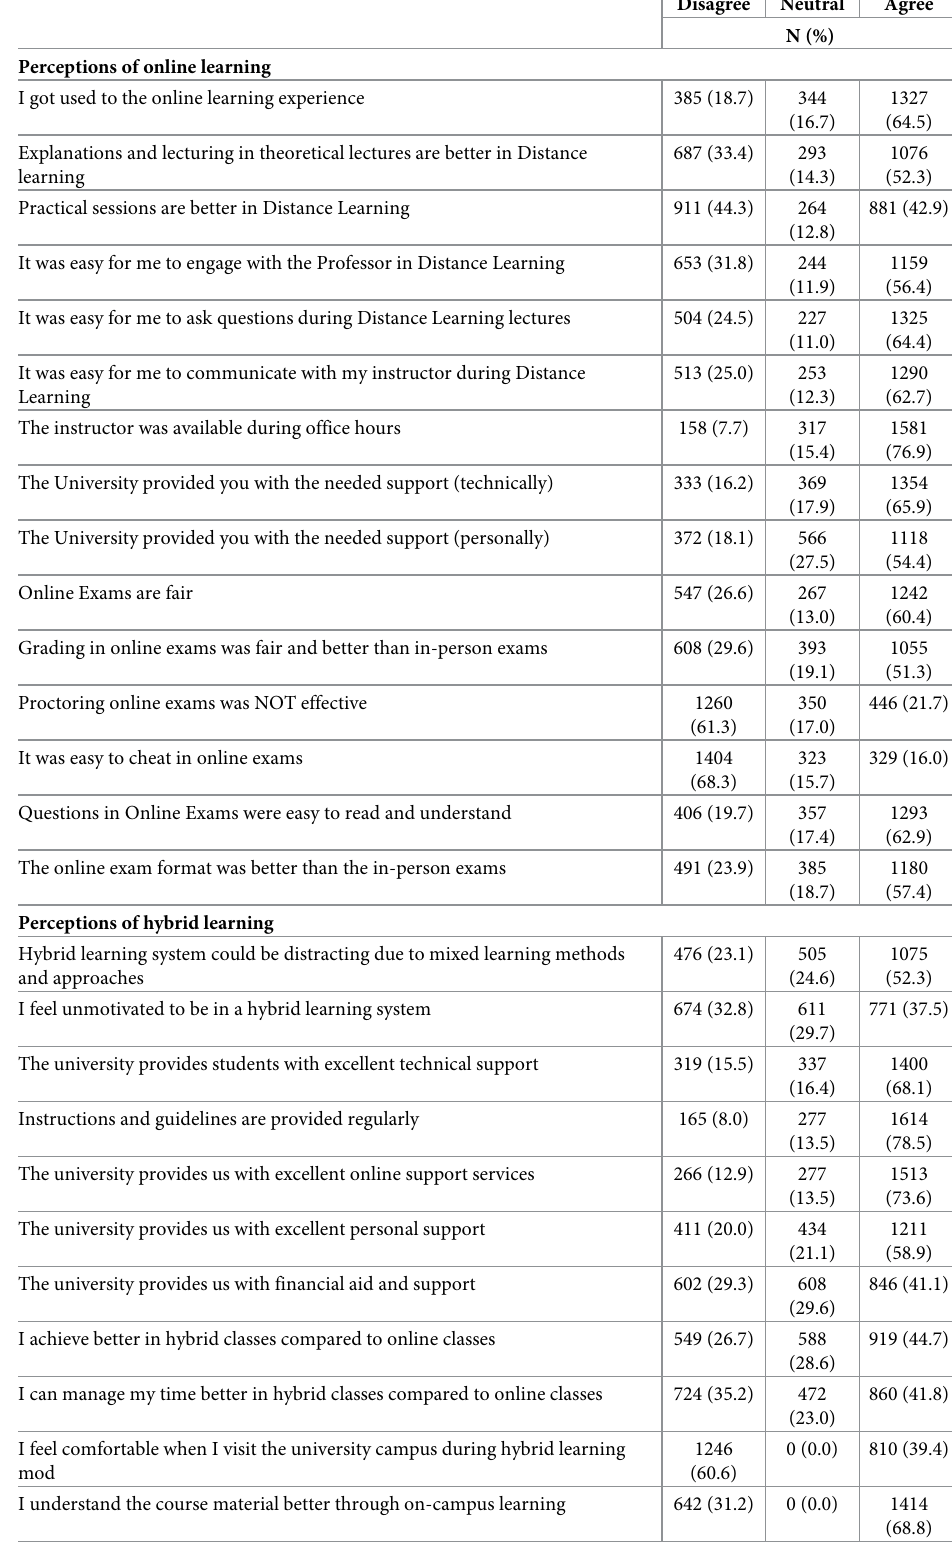
Table 2. Students’ perceptions of online and hybrid learning (n =